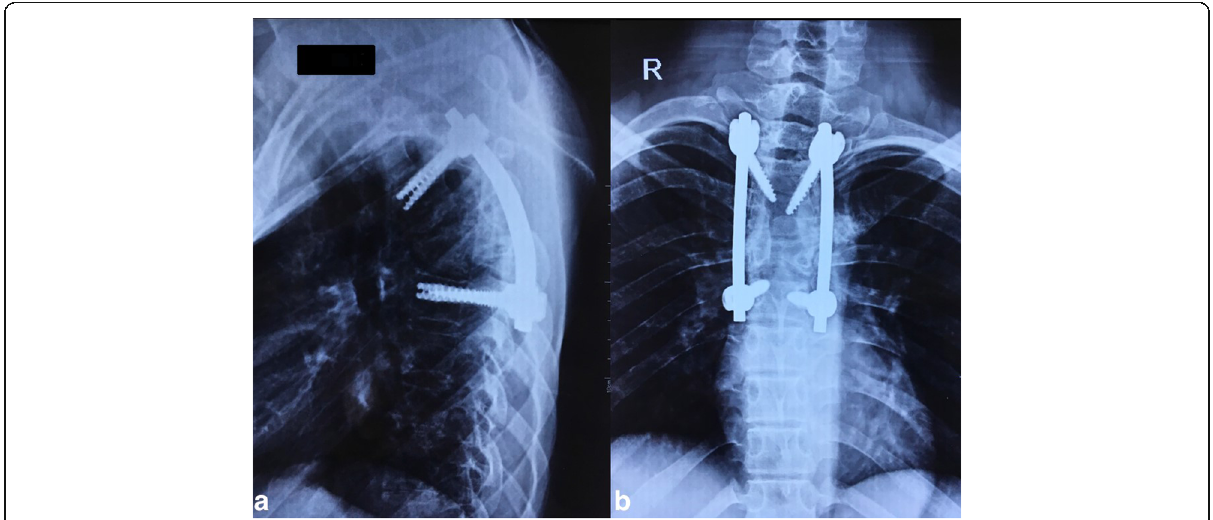
Fig. 8 Postoperative 27-month follow-up radiographs ( a , b ) showing maintenance of alignment, no loss of correction, or implant failure. The final mJOA score was